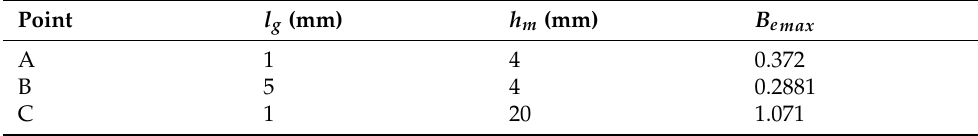
Table 2. Variation of Bemax as a function of l g and h m